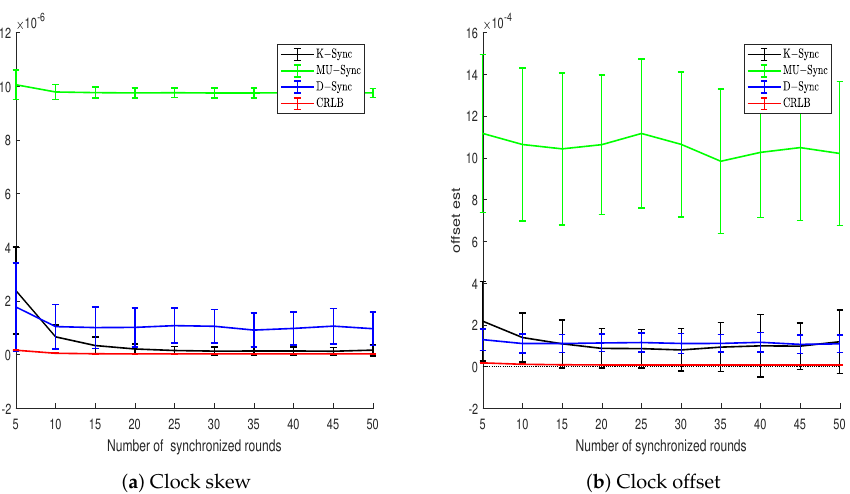
Figure 5. Clock parameters estimation error vs. number of synchronized rounds (Model